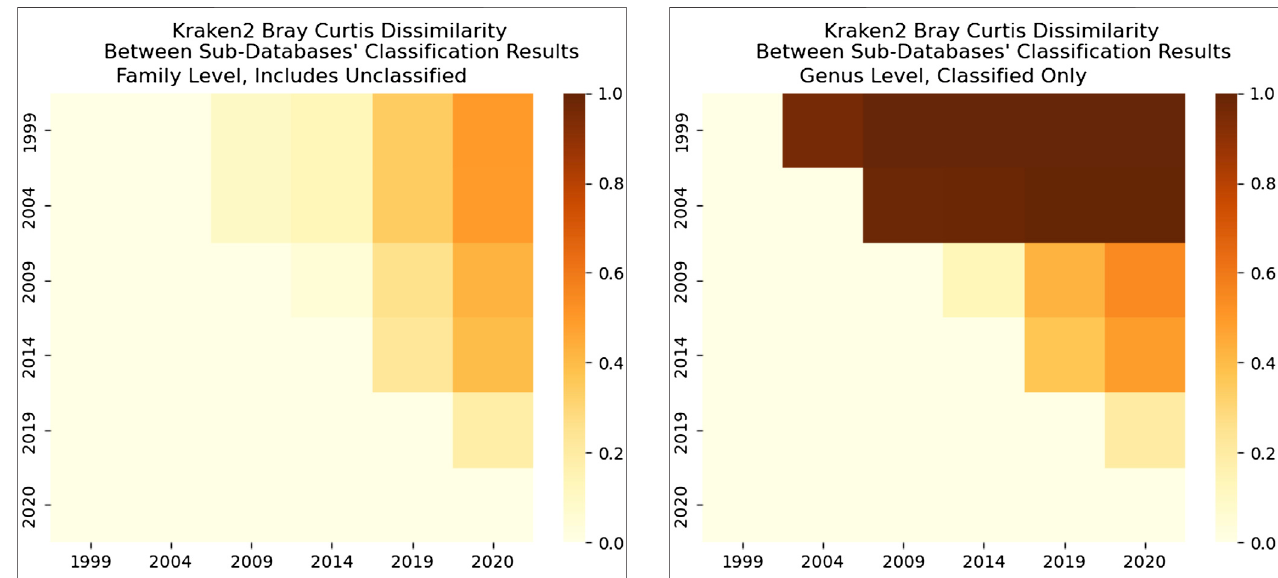
FIGURE 17 | Kraken 2 ’ s Bray-Curtis dissimilarity score for Family level. It is a comparison between each sub-databases ’ classi fi cation results for Kraken 2. It includes comparisons of what Kraken 2 classi fi ed as well as what it didn ’ t classify for each year. Unlike CLARK, Kraken 2 ’ s most similar results are from the 1999 and 2004 databases.